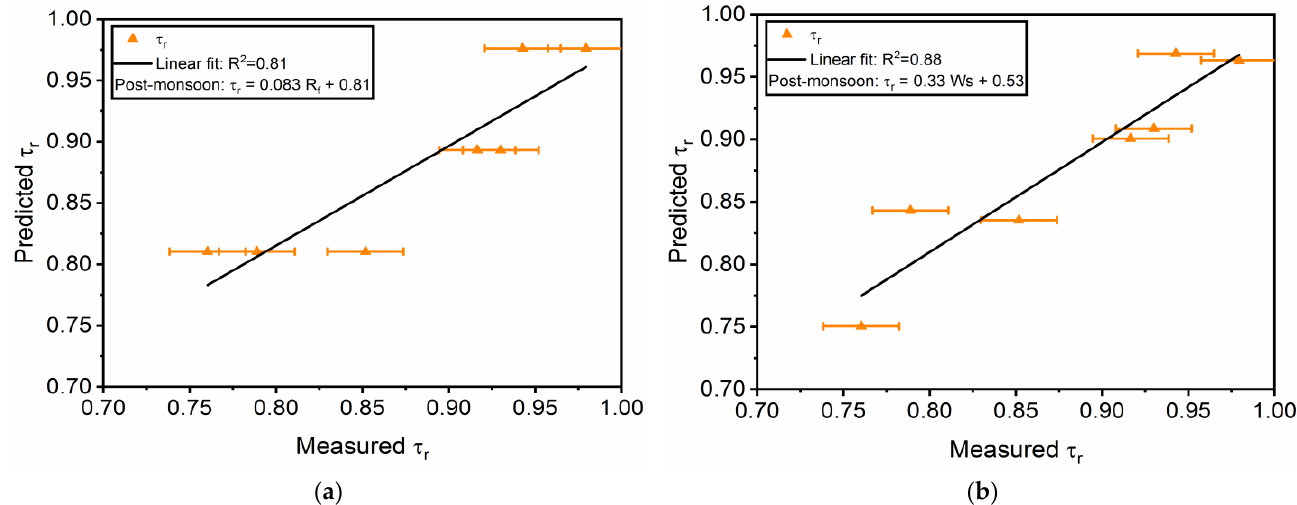
Figure 11. Regression plot of predicted transmittance and measured transmittance of weekly cleaned glass (G2) using the MLR model during the post-monsoon season for the environmental parameters: ( a ) R f and ( b ) Ws . The uncertainty associated with the average relative direct transmittance of the weekly cleaned glass coupon during post-monsoon is ±0.022.